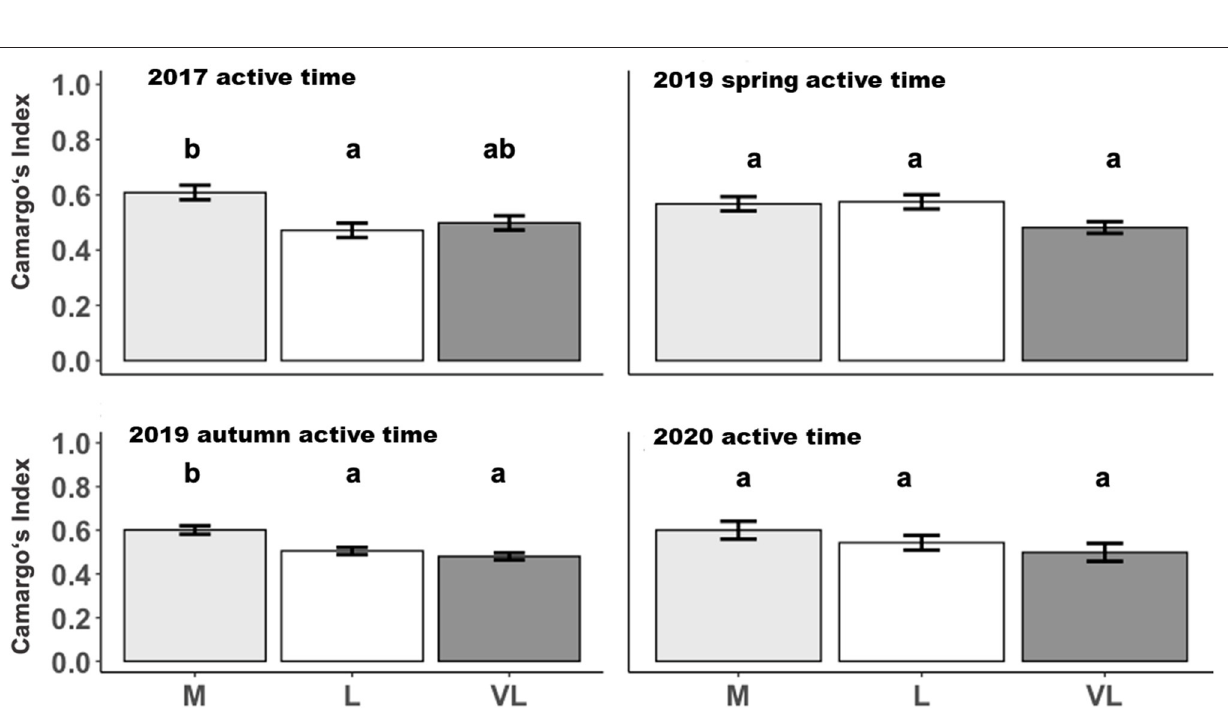
Frontiers in Veterinary Science |